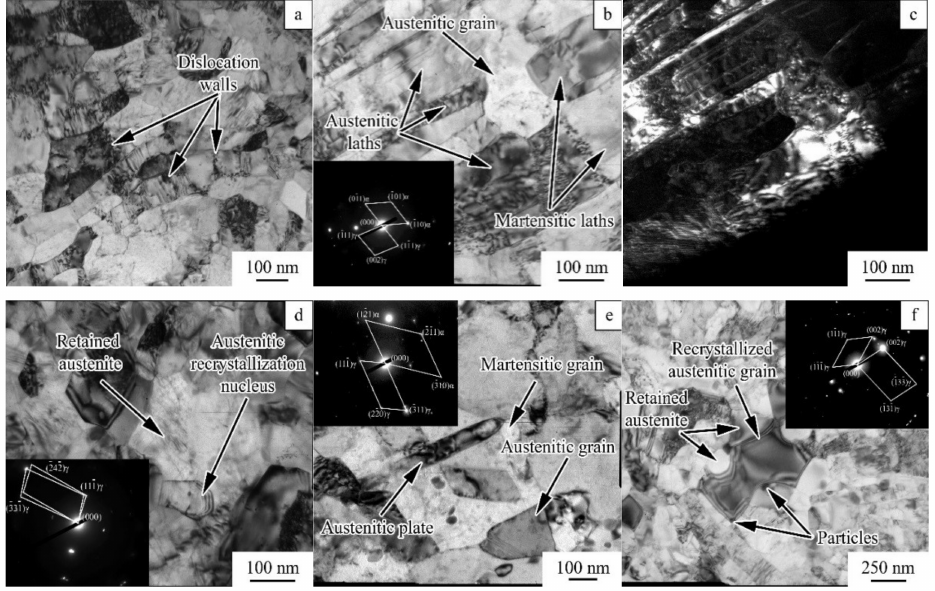
Figure 6. TEM micrographs in the transversal section after annealing at ( a ) 500, ( b – d ) 550, ( e ) 600, and ( f ) 650 ◦ C: ( a , b , d – f )—bright-field images; ( c )—dark-field image from ( b ) at the